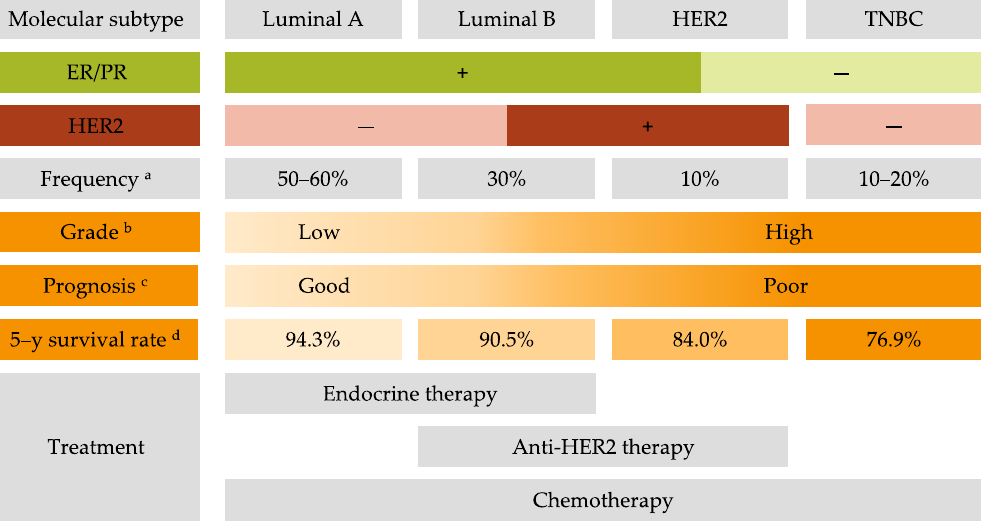
Figure 1. Characteristics of breast cancer molecular subtypes. ER: estrogen receptor; PR: progesterone receptor; HER2: human epidermal growth factor receptor 2; TNBC: triple-negative breast cancer. a . Frequency derived from Al-thoubaity et al. [12] and Hergueta-Redondo et al. [13]. b . Grade derived from Engstrom et al. [14]. c . Prognosis derived from Hennigs et al. [15] and Fragomeni et al. [16]. d . The 5–year survival rate derived from the latest survival statistics of SEER [7].